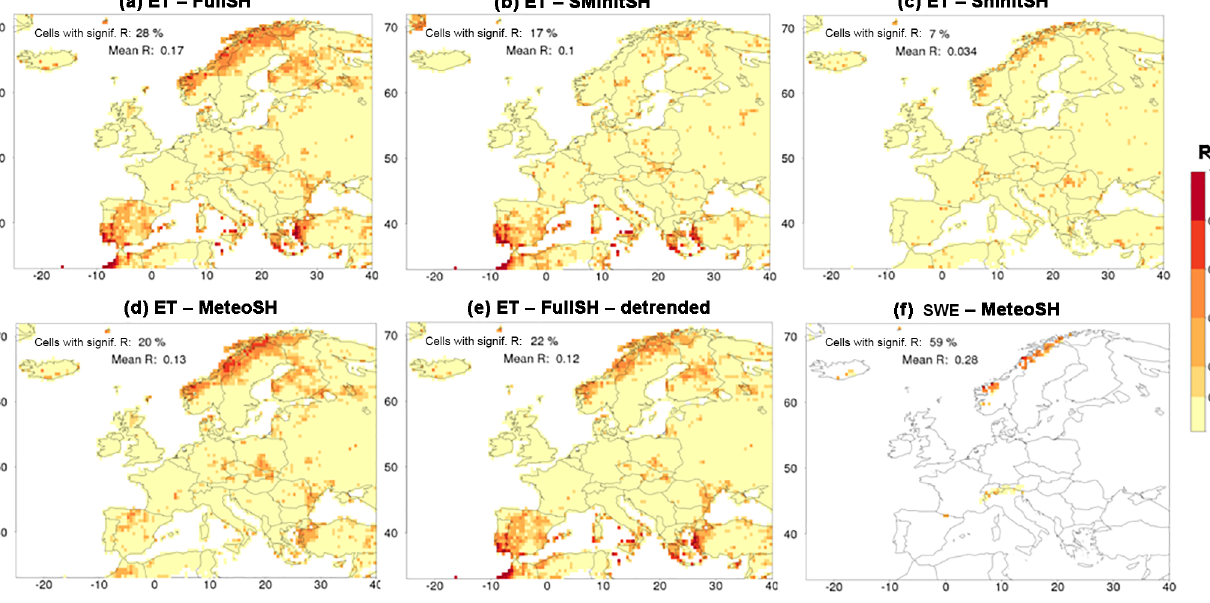
Figure 11. Explanation of the skill in the hindcasts of evapotranspiration (ET) for July by taking lead month 5 as an example. The panels map the skill in evapotranspiration of the FullSHs (a) , SMInitSHs (b) , SnInitSHs (c) , MeteoSHs (d) and the FullSHs after detrending (e) . (f) depicts skill of the hindcasts of snow-water equivalent (SWE) in the MeteoSHs. For more explanation, see Fig. 1a. Note that statistics in the legends of the panels refer only to that part of the domain for which R was computed, which consists of all coloured